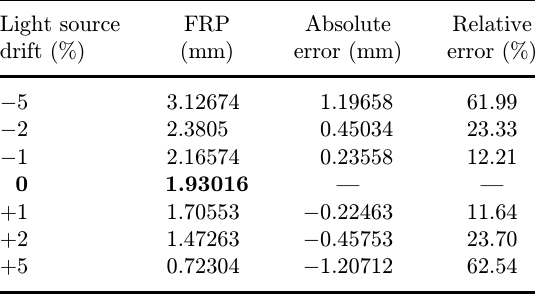
Table 9. Errors of light source drift for di®erent levels with